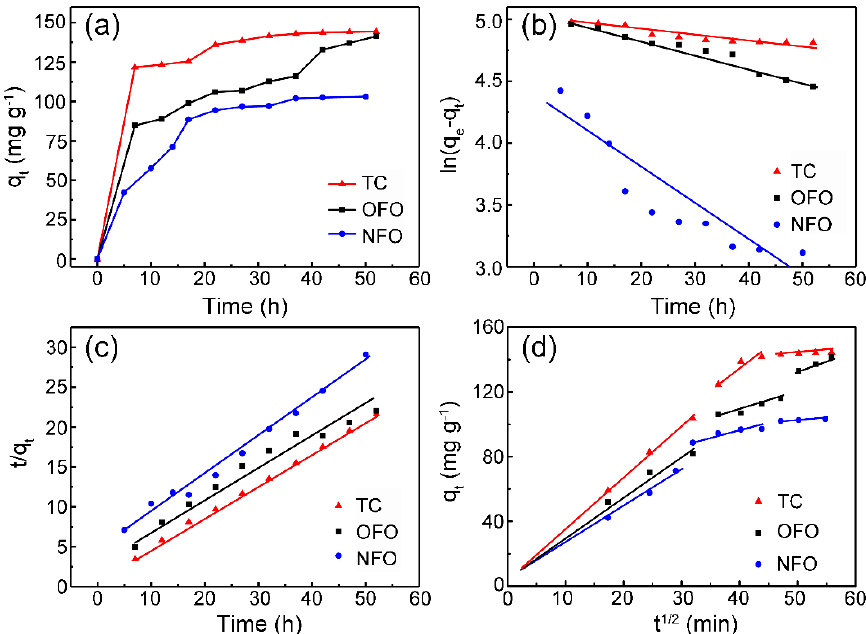
Figure 5. ( a ) Time curve fitting; ( b ) pseudo-first-order kinetic model; ( c ) pseudo-second-order kinetic model; and ( d ) the intra-particle diffusion model of ZHC. Table 3. The related fitting parameters of the kinetic model.